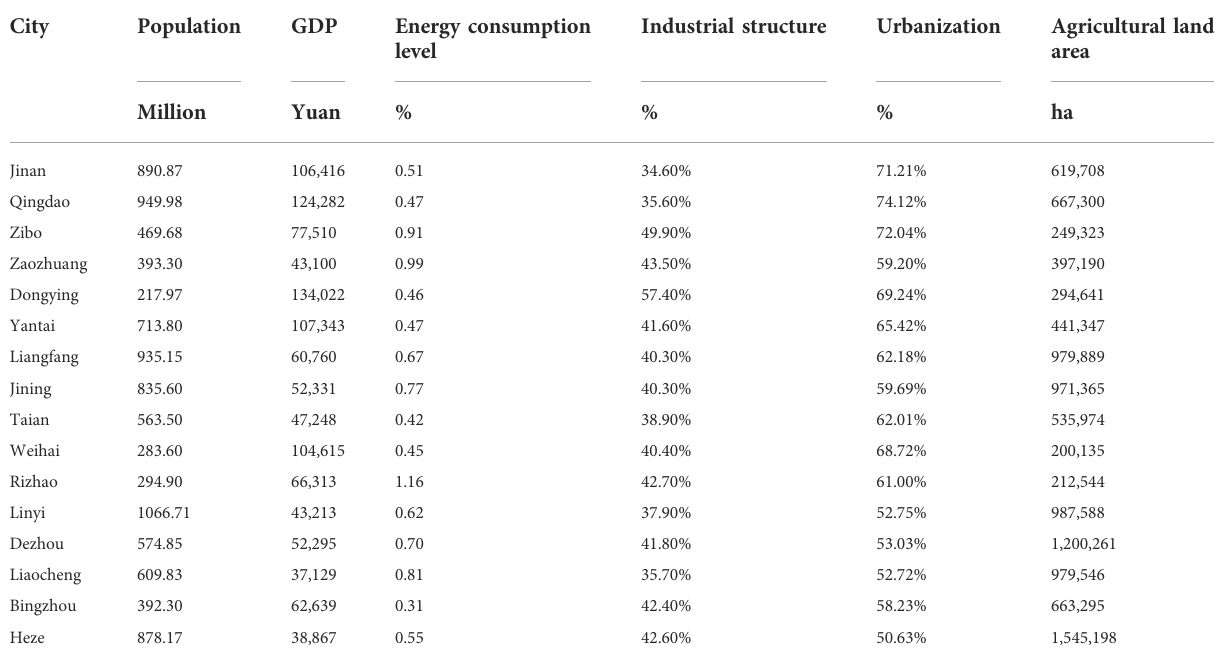
TABLE 2 Static indicator data by city.